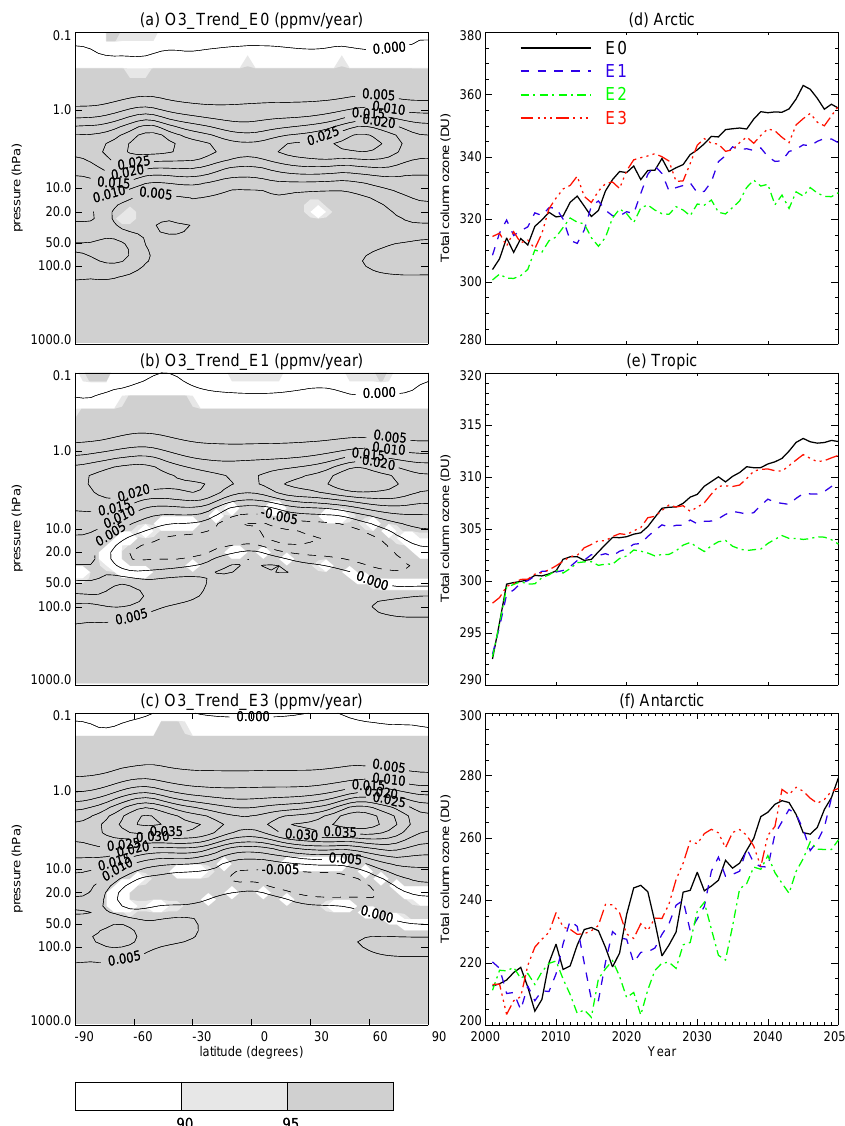
Figure 3. (a, b, c) Latitude–pressure cross sections of the long-term (2001–2050) trends of zonal mean ozone mixing ratios (ppmvyr − 1 ) in WACCM experiments E0, E1 and E3. The contour interval is 0.005ppmvyr − 1 . Grey colours represent statistic significance levels of the trends. (d, e, f) Time series of TCO in different regions (Arctic, Tropics, Antarctic) in experiments E0 (black line), E1 (blue dashed line), E2 (green dashed-dotted line) and E3 (red dashed-dotted line). To make the lines easily identified, the time series has been smoothed by nine-point